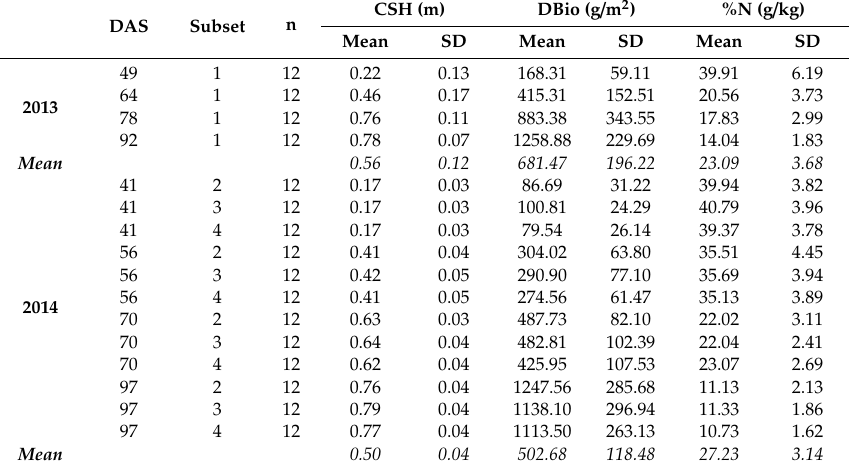
Table 2. Statistics for the plot-wise averaged crop surface height (CSH), the destructively taken dry biomass (DBio), and nitrogen concentration (%N) measured in the laboratory. The values were calculated for subset 1 of 2013 and subsets 2, 3, and 4 of 2014 (DAS: Day after seeding; n: number of samples; mean: mean value; SD: standard